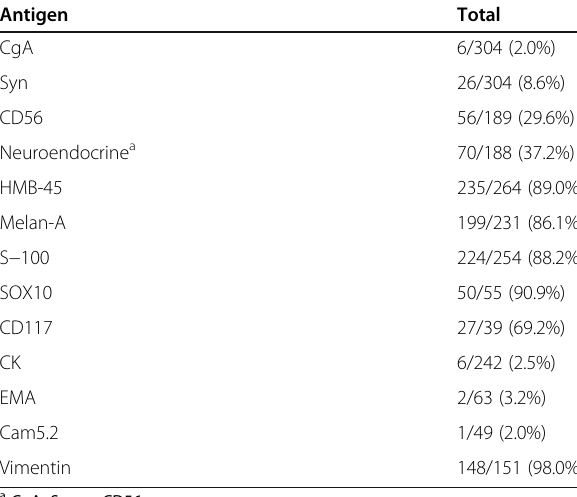
Table 2 Immunohistochemical findings